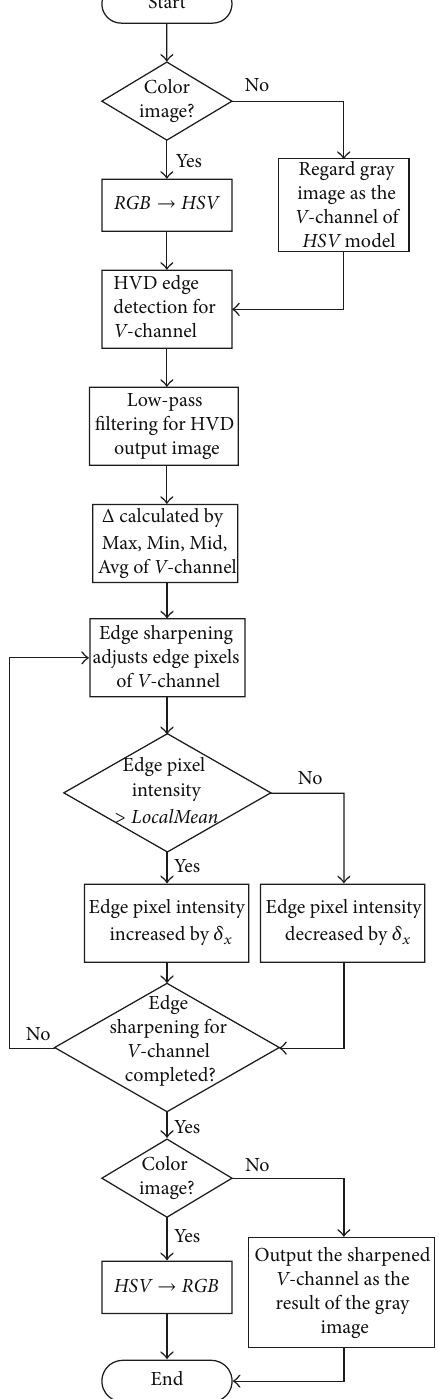
Figure 3: Procedure for the proposed color image sharpening